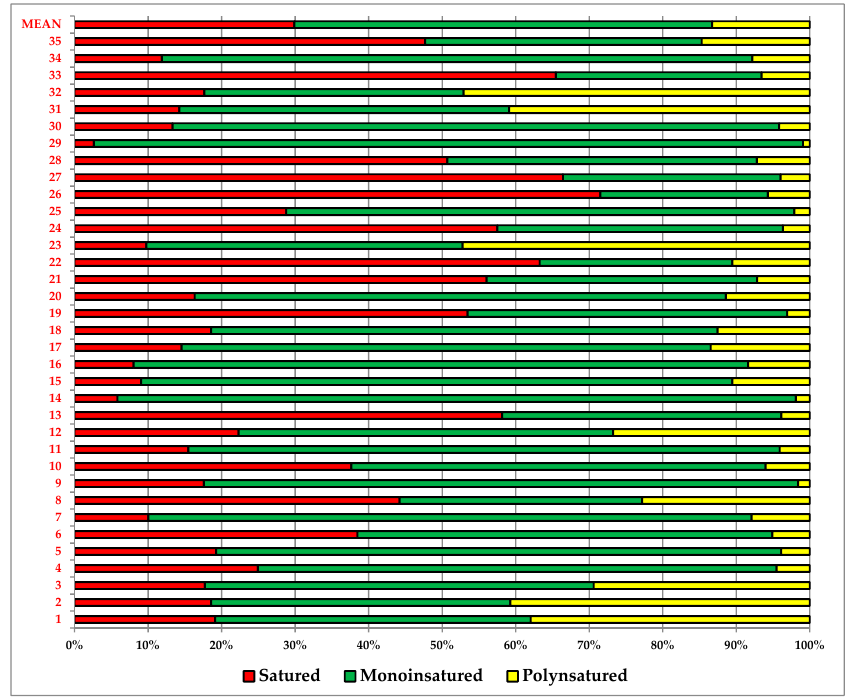
Figure 3. Saturated, mono-, and polyunsaturated fatty acids in the gluten-free samples. In the analyzed samples, the mean percentage of the total lipids was 12.6%. The highest contents were found in the samples n° 26 (wafer biscuit) (25%) and n° 28 (muffin) (23%), while the lowest content was found in the sample n° 3 (flour mix for bread) (1.2%).